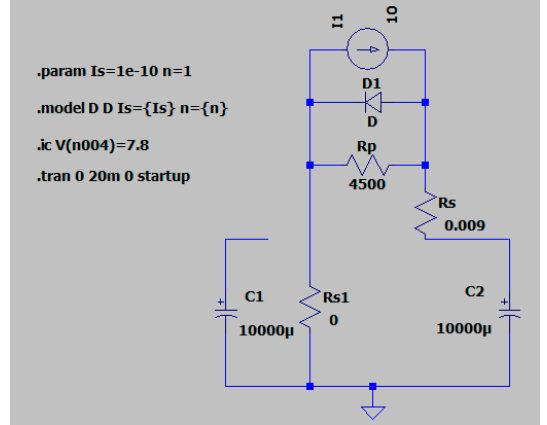
Figure 9. Circuit simulated in LTSpice for estimating the duration of step 6 of the process with the chosen capacitors and voltages.